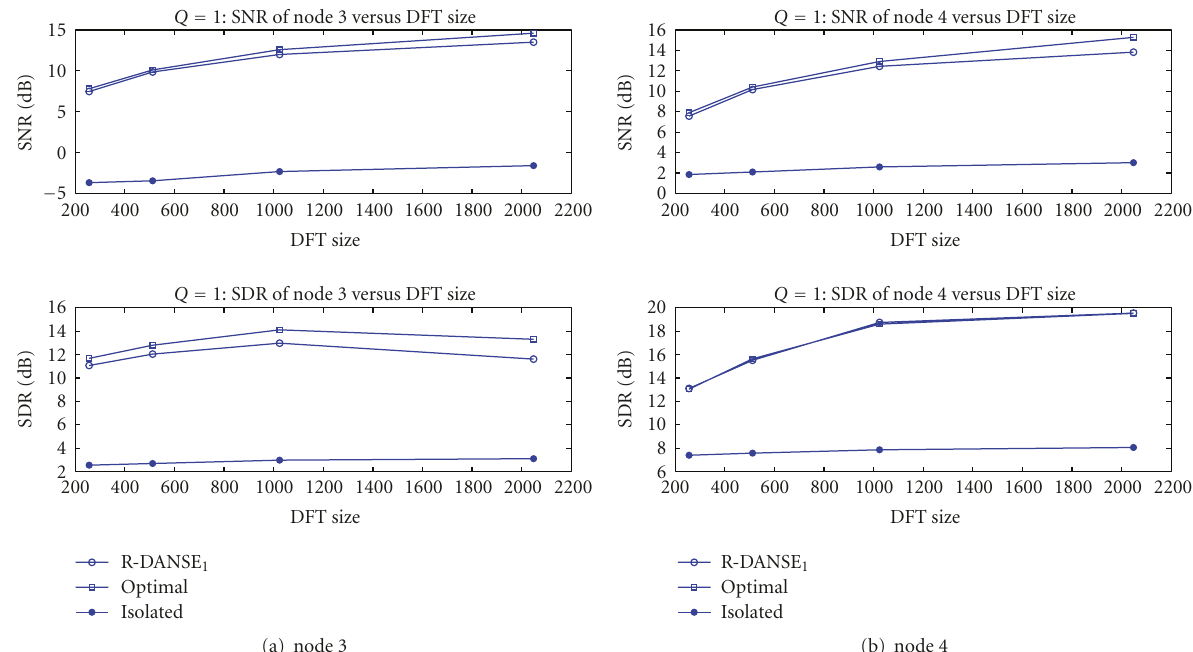
Figure 9: Output SNR and SDR after 28 iterations of R-DANSE 1 with sequential updating versus DFT size L at nodes 3 and 4.